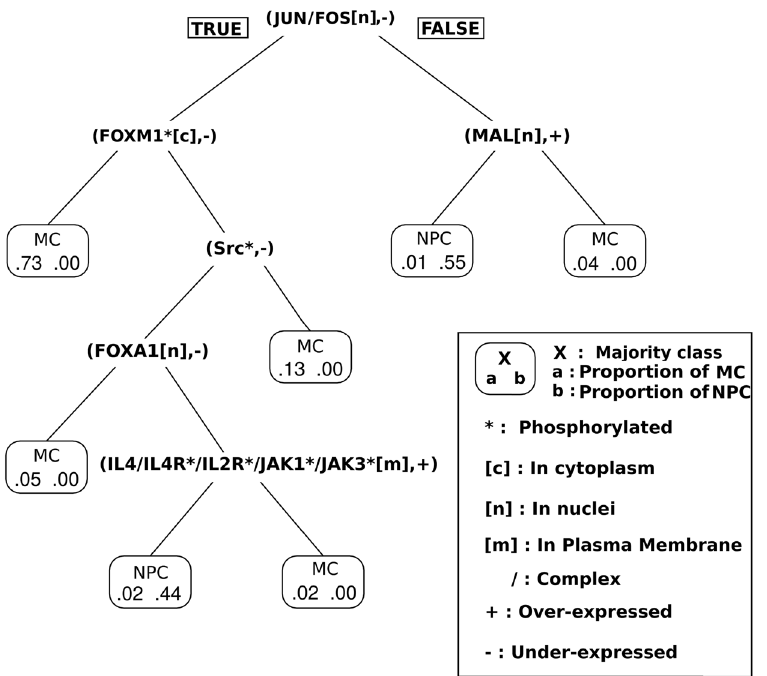
Figure 4. Decision tree based on predicted node-sign